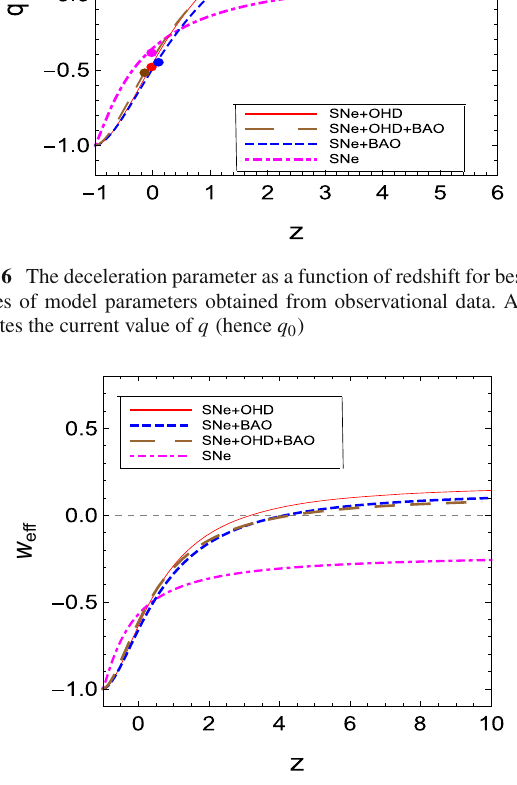
Fig. 7 The variation effective EoS parameter as a function of redshift for best-fit values of model